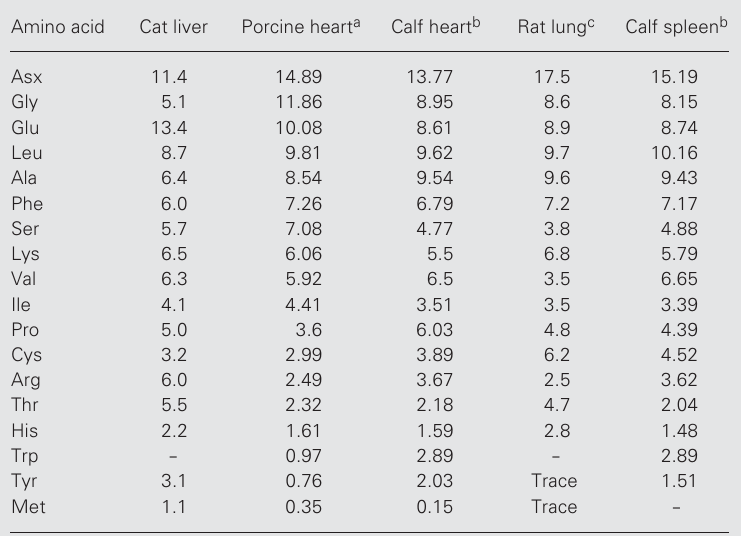
Table 4. Comparison of the amino acid composition of cat liver lectin with other S-type mammalian galectins. Amino